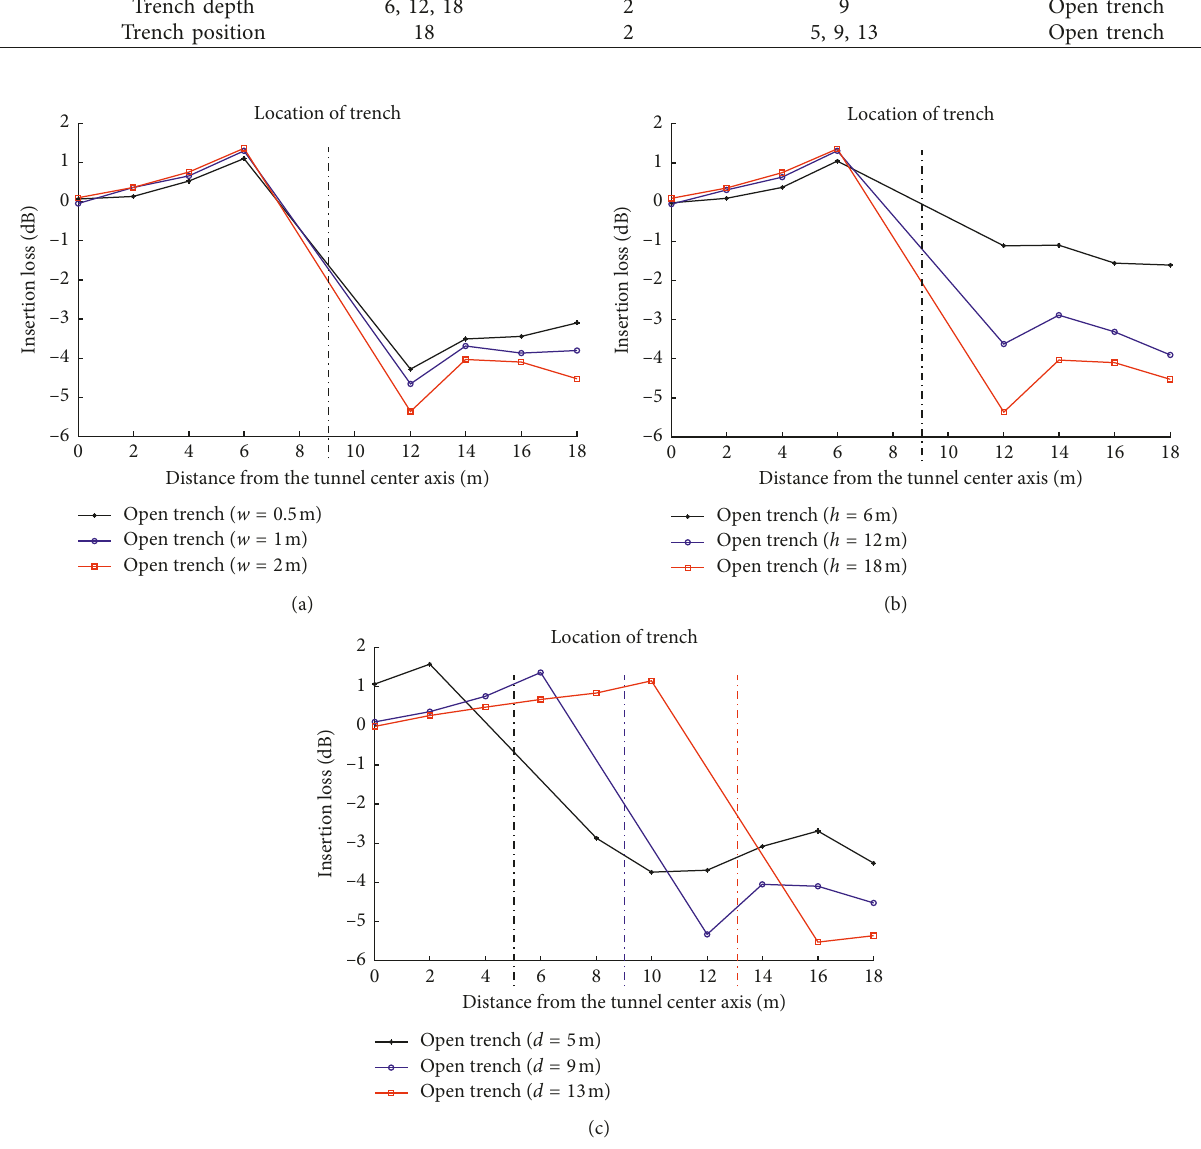
Figure 11: Insertion loss at the surface of the ground. (a) Different trench widths. (b) Different trench depths. (c) Different trench